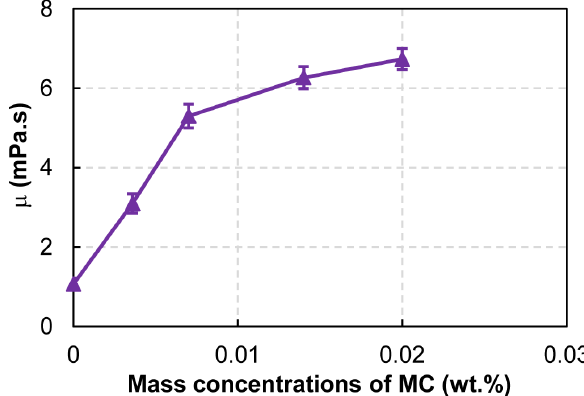
Figure 7: Variations of µ of the diluted MC-MWCNT suspensions ver- sus mass content of MC. Error bars indicate one standard deviation